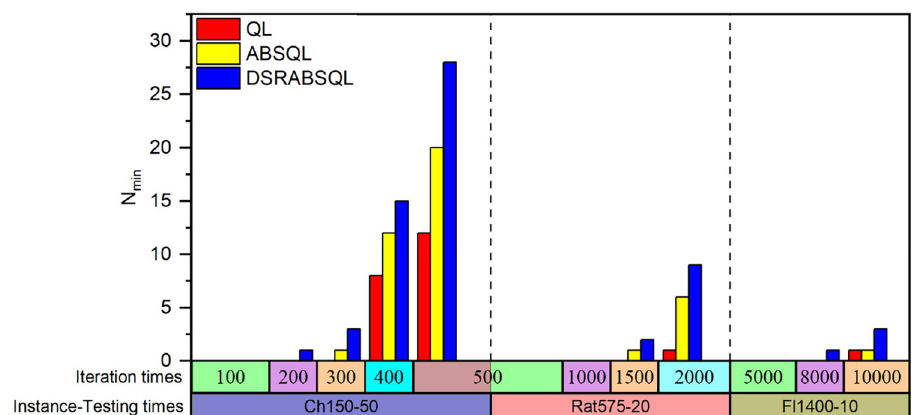
Fig 10. The value of N min for ch150, rat575 and fl1400 obtained by three algorithms.